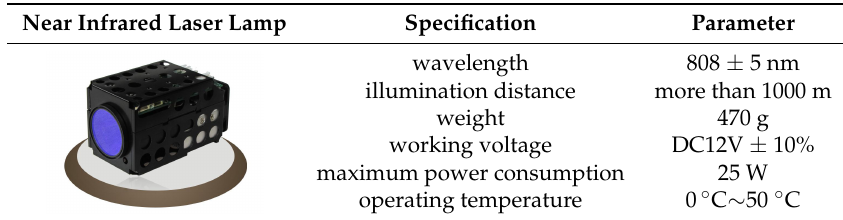
Table 1. The near infrared laser lamp